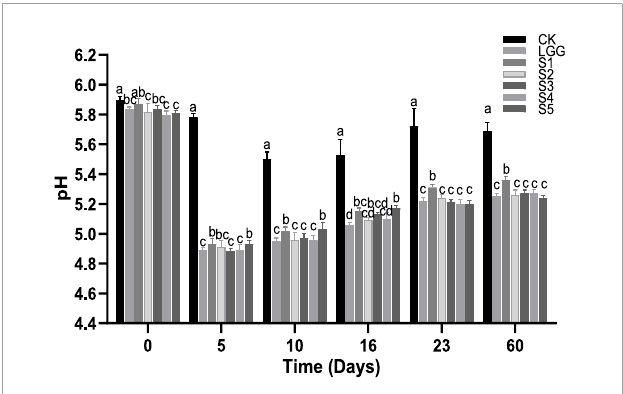
FIGURE4 Evolution of pH value during the ripening of the different samples of sausage. Different letters indicate that there is significant difference in pH value between different groups of fermented sausage at the same time ( p < 0.05).